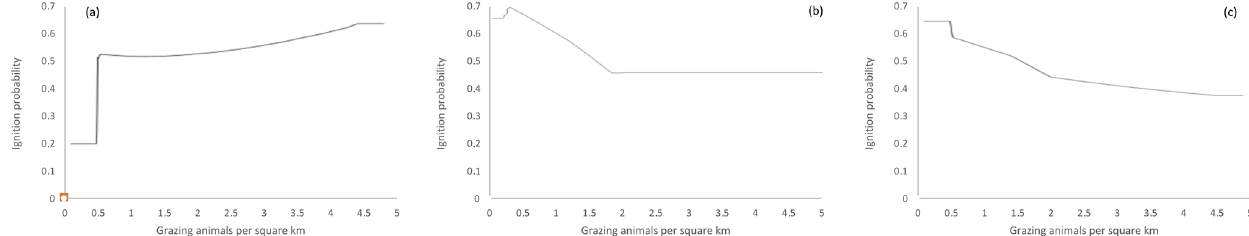
Figure 8. MaxEnt response curve for the effect of density of grazing domestic animals on ignition probability in summer fires (a) , winter forest (b) , and winter agropastoral fires (c) .